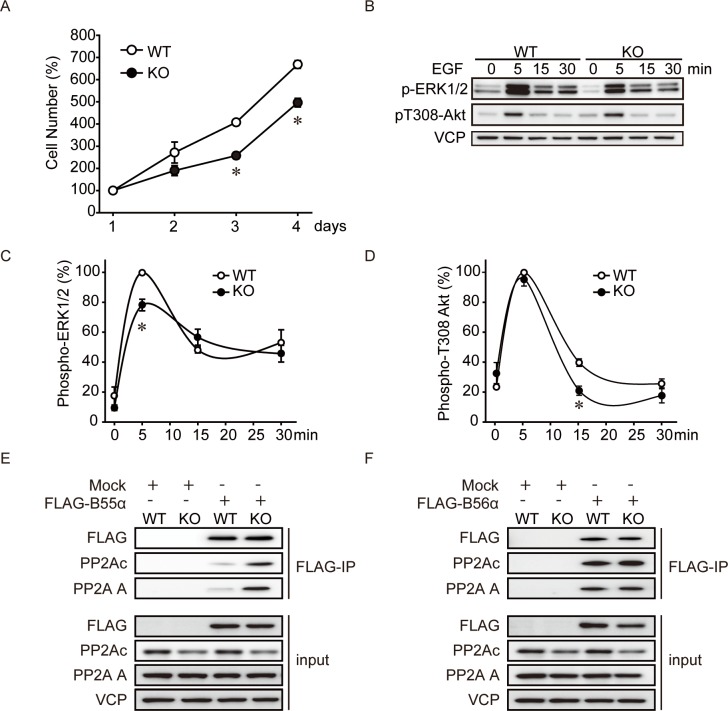
PME-1 knockout suppresses cell proliferation.(A) Loss of PME-1 suppresses cell proliferation. Cell proliferation of wild type (WT) and PME-1 KO (KO) MEFs were determined by Cell Counting Kit-8. N = 4 *: P<0.05 vs. WT. (B-D) Effects of PME-1 KO on ERK1/2 and Akt phosphorylation. WT and KO MEFs were stimulated with EGF (50 ng/ml) for indicated time periods and ERK1/2 and Akt phosphorylation was determined by immunoblotting. Representative images (B) from 3 independent experiments, and quantitative data for phospho-ERK1/2 (C) and phosphoT308 Akt (D) are shown. *: P<0.05 vs. WT. (E-F) Loss of PME-1 enhances the association of PP2A AB55αC complex. FLAG-B55α or B56α were transiently expressed in WT and PME-1 KO MEFs, and immunoprecipitated with FLAG-M2 beads. Empty vector was used as mock. PP2Ac and A subunit association was detected by immunoblotting. Representative images from 3 independent experiments were shown.